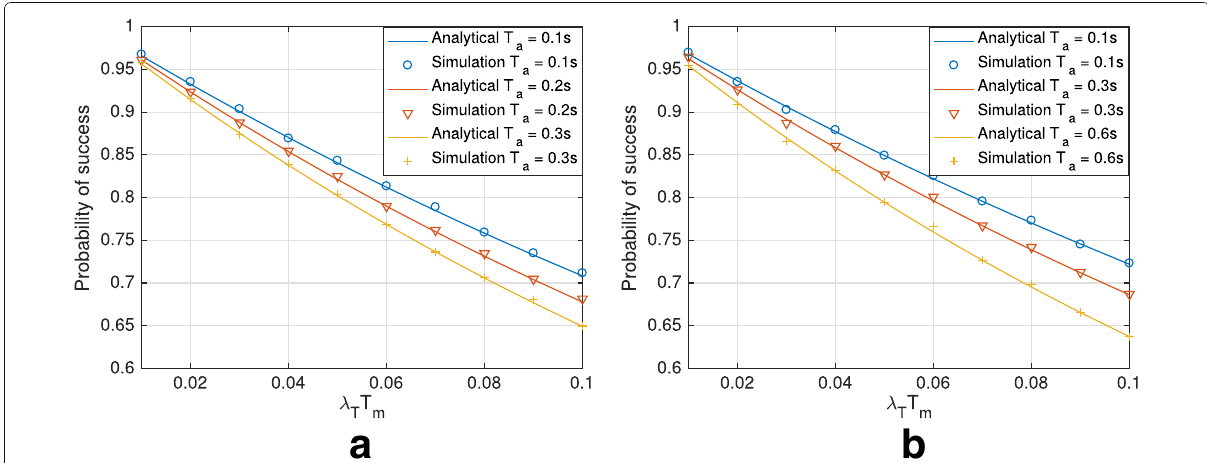
a b Fig. 10 Probability of success P ( sd ) versus λ T T m . These results are obtained with T d = 1 s and with various values of T a and T m which are compliant with the LoRaWAN standard. a T m = 0.4 s. b T m = 0.7 s